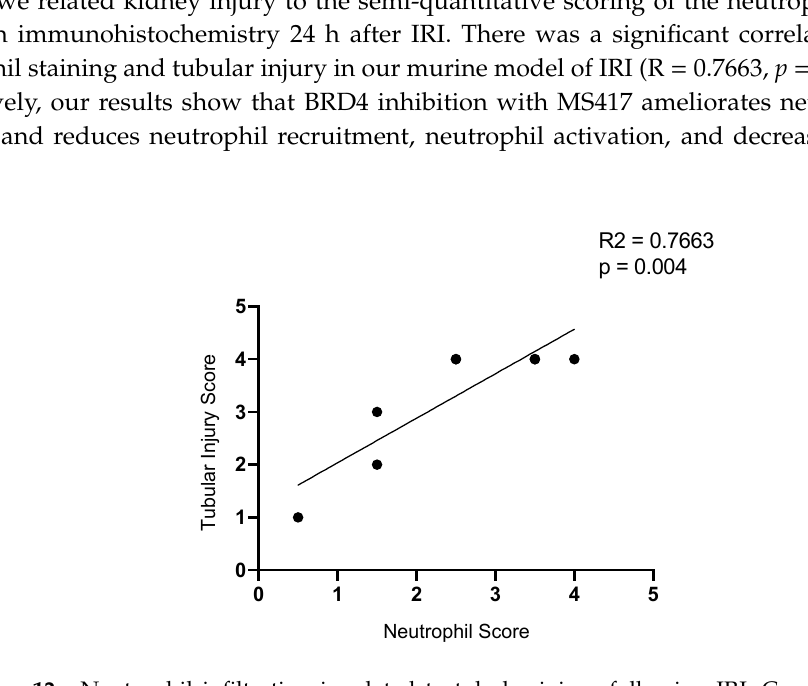
Figure 12. Neutrophil infiltration is related to tubular injury following IRI. Correlation plot of semi-quantitative scoring performed in a blinded manner of tubular injury and neutrophil infiltration at 24 h-post IR (R2 = 0.7663, p = 0.004). n = 8 (two sets of mice had the same scores so are overlapped)